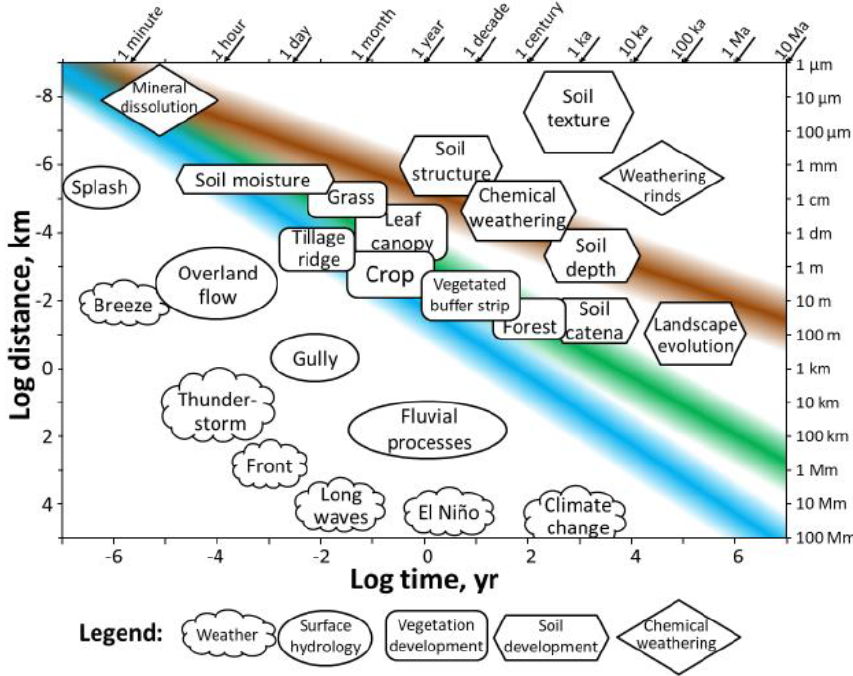
Figure 2. Organization of hydrologic processes according to spatial and temporal scales with logarithmic axes (modified after Loague and Corwin, 2006). Thus, a constant slope on this figure represents the value of a power in a power law. The blue strip represents water flow distances for scale-invariant flow rates as a function of time and has a slope of 1. The green strip denotes root radial extent (and vegetation height) as a function of time and has a slope of 0.83. The brown strip represents soil depth as a function of time and has a slope of 0.53. These slopes less than 1 imply that vegetation physical extent and soil depth have decreasing growth rates with time. The particular exponents that govern these scaling relationships are the optimal path exponent in two dimensions for vegetation growth and the percolation backbone in three dimensions for soil formation. See the text for further